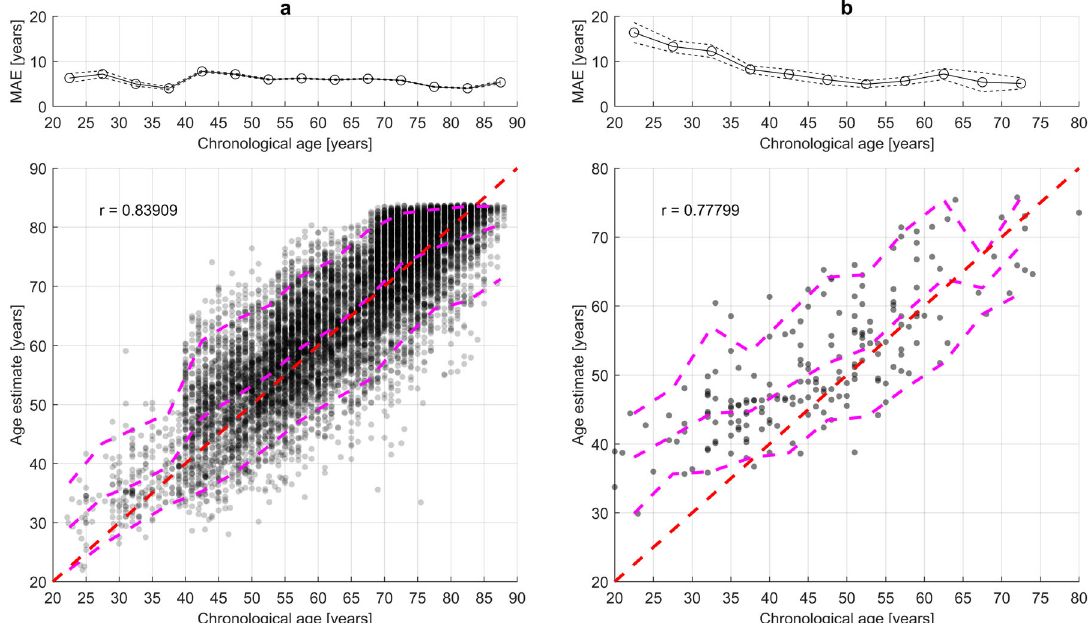
Fig. 1 Scatterplot of age estimate and chronological age in the test sets for model (e, Ensemble – Avg.). a The test set ( n = 9899). The dotted line indicates the standard error of the mean (SEM) calculated as σ = optimal age estimate; the magenta lines indicate 5th, 50th, and 95th percentiles of age estimate in 5-year intervals. r is Pearson ’ s correlation coef fi cient between age estimate and chronological age. MAE: mean absolute